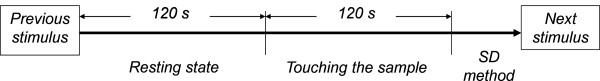
Experimental protocol.